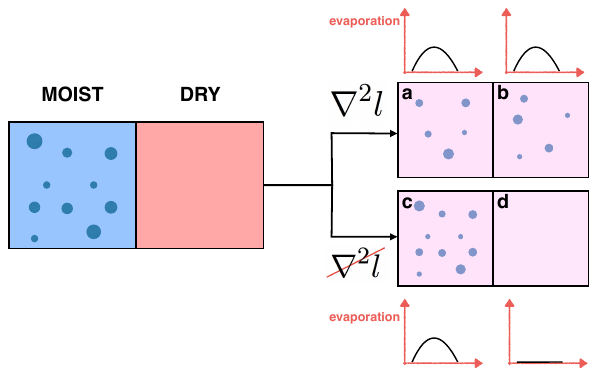
Figure 1. The left side represents a cloudy moist parcel and an un- saturated parcel before mixing. The right side represents the mixing processes in the Eulerian and Lagrangian formulations. In the Eule- rian formulation (top) there is diffusion of liquid from the saturated into the unsaturated parcel. In the Lagrangian formulation (bottom) there is no diffusion, and the initially saturated parcel remains free of liquid. As a consequence, liquid water evaporates in both parcels in the Eulerian formulation, but only in the initially saturated parcel in the Lagrangian formulation. Consequently, the evaporation of in the Eulerian formulation is consistently